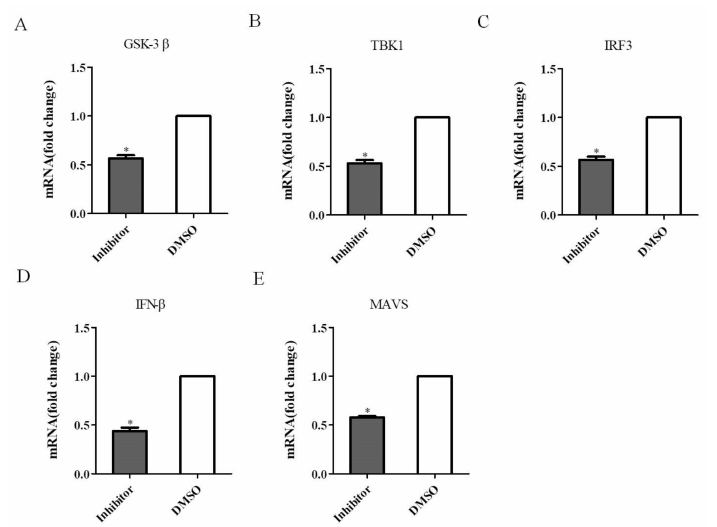
Figure 9. Effect of GSK-3 β -associated signaling on TBK1 in antiviral signaling. For qRT-PCR analysis, DEF cells were treated with 60 µ M GSK-3 β inhibitor for 24 h and infected with DEV at a MOI of 0.1 as an experimental group and treated with DMSO as the carrier control. ( A ) GSK-3 β mRNA expression levels. ( B ) TBK1 mRNA expression levels. ( C ) IRF3 mRNA expression levels. ( D ) IFN- β mRNA expression levels. ( E ) MAVS mRNA expression levels. Mean ± SD of three technical replicates are shown. * p <